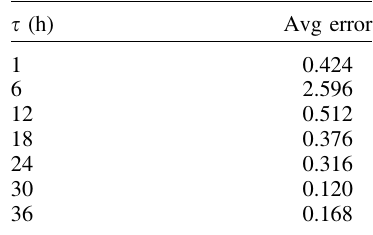
Table 1. Average prediction errors. Table 2. Feature vector correlation values 31 24-hour